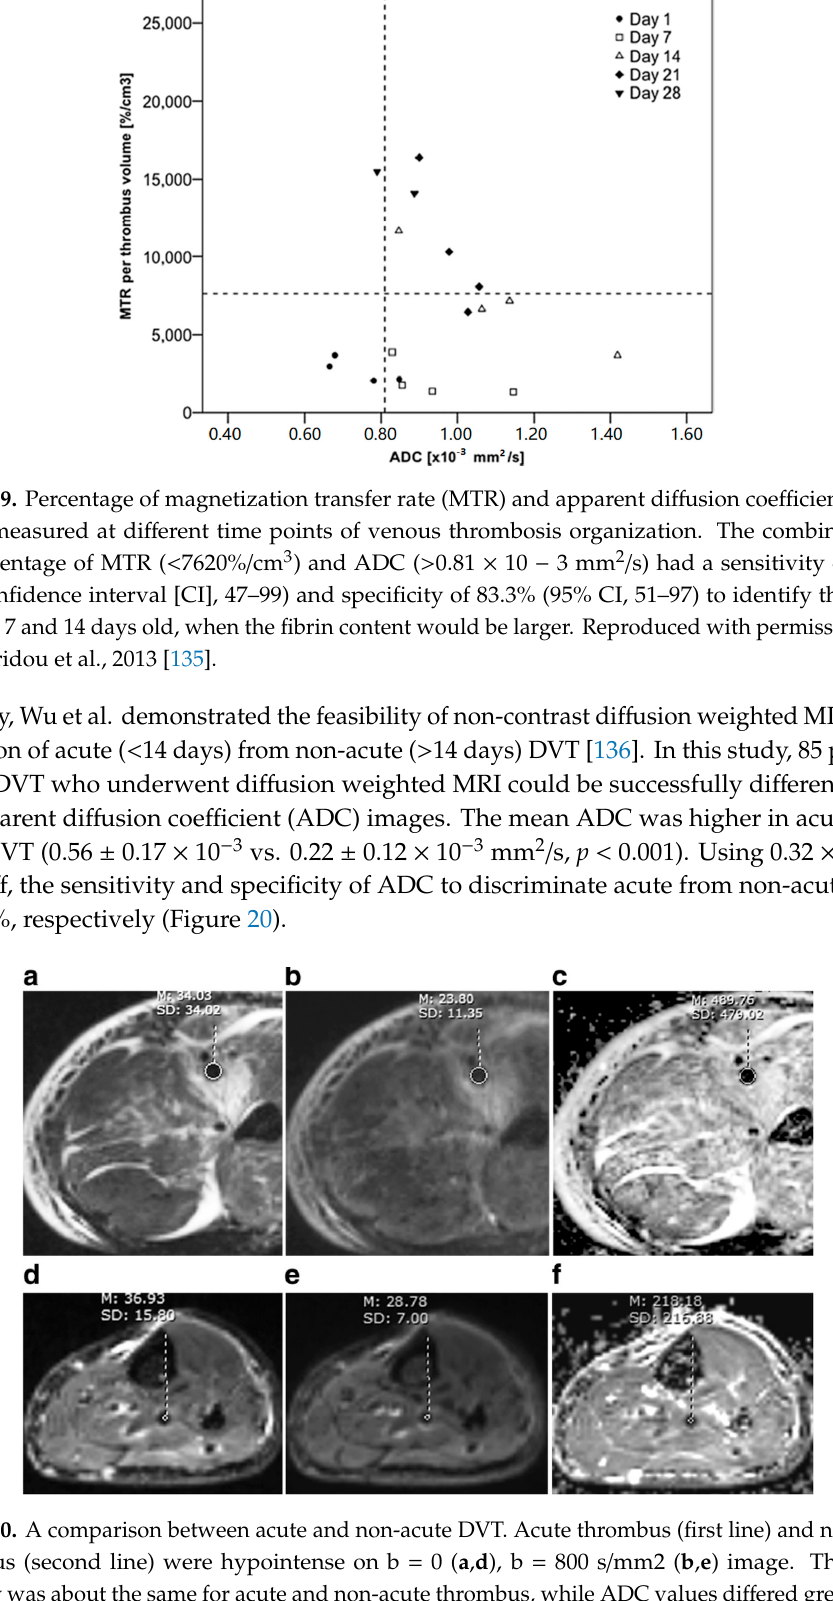
14 of 42 indicates analysis of variance; d—day; and MSB—Martius Scarlet Blue. Reproduced with permission